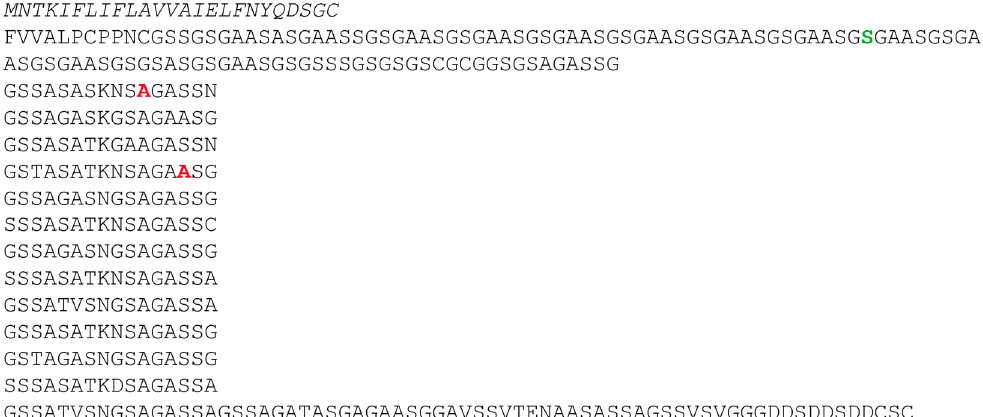
Figure 1. Amino acid sequence of ChryC3 (Genbank accession no.: KY906178). Italics: signal sequence, predicted by SignalP 4.1. Red marked amino acid residues: positions with detected single nucleotide polymorphisms (SNPs) in the cDNA library: gct (Ala) → act (Thr). Green marked amino acid residue: silent SNP (tca → tcg).